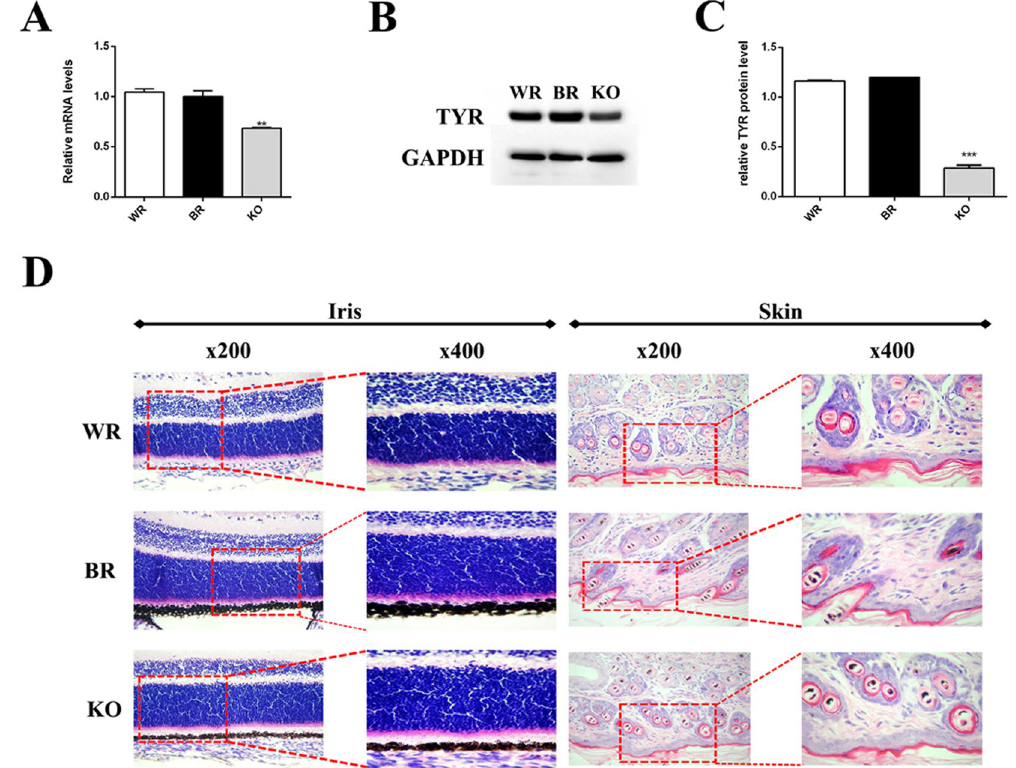
Figure 3. Reduced expression of melanin in Tyr 3 ′ UTR deleted rabbit. ( A ) Expression of Tyr gene was determined by qRT-PCR. ( B ) Tyr protein was determination by Western Blot. ( C ) Gray-scale analysis of the Tyr protein by ImageJ software. ( D ) H&E staining of the iris and skin from the WR, BR and KO rabbits. All the data are expressed as the mean ± SEM. * P < 0.005; ** P < 0.001; *** P < 0.005. BR, black rabbit; WR, white rabbit; KO, Tyr 3 ′ UTR deleted